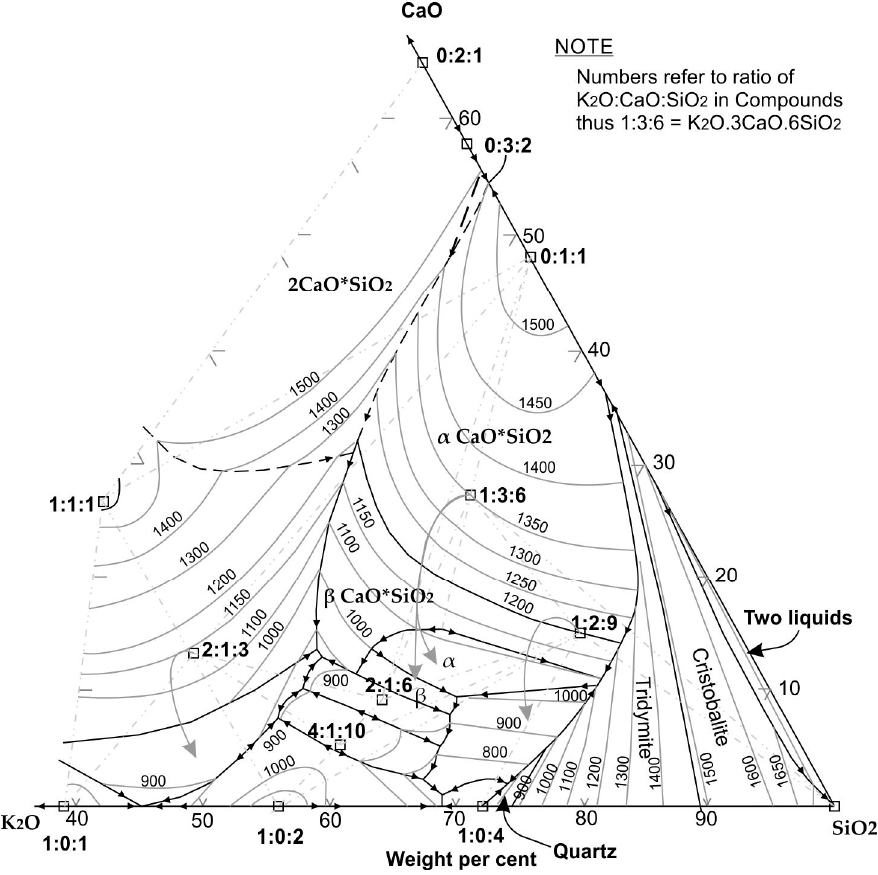
Figure 6. Detail of the K 2 O ‐ CaO ‐ SiO 2 ternary system [25].